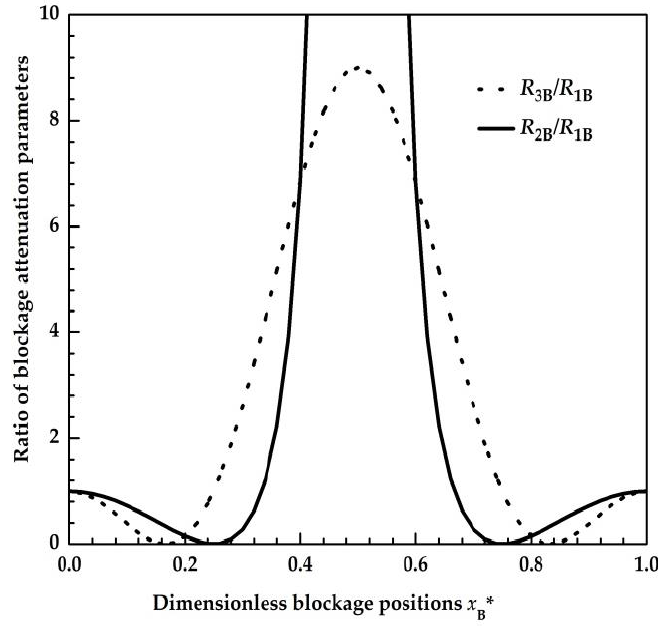
R values at different blockage locations. Figure 4. Ratio curves of different R nB values at different blockage nB